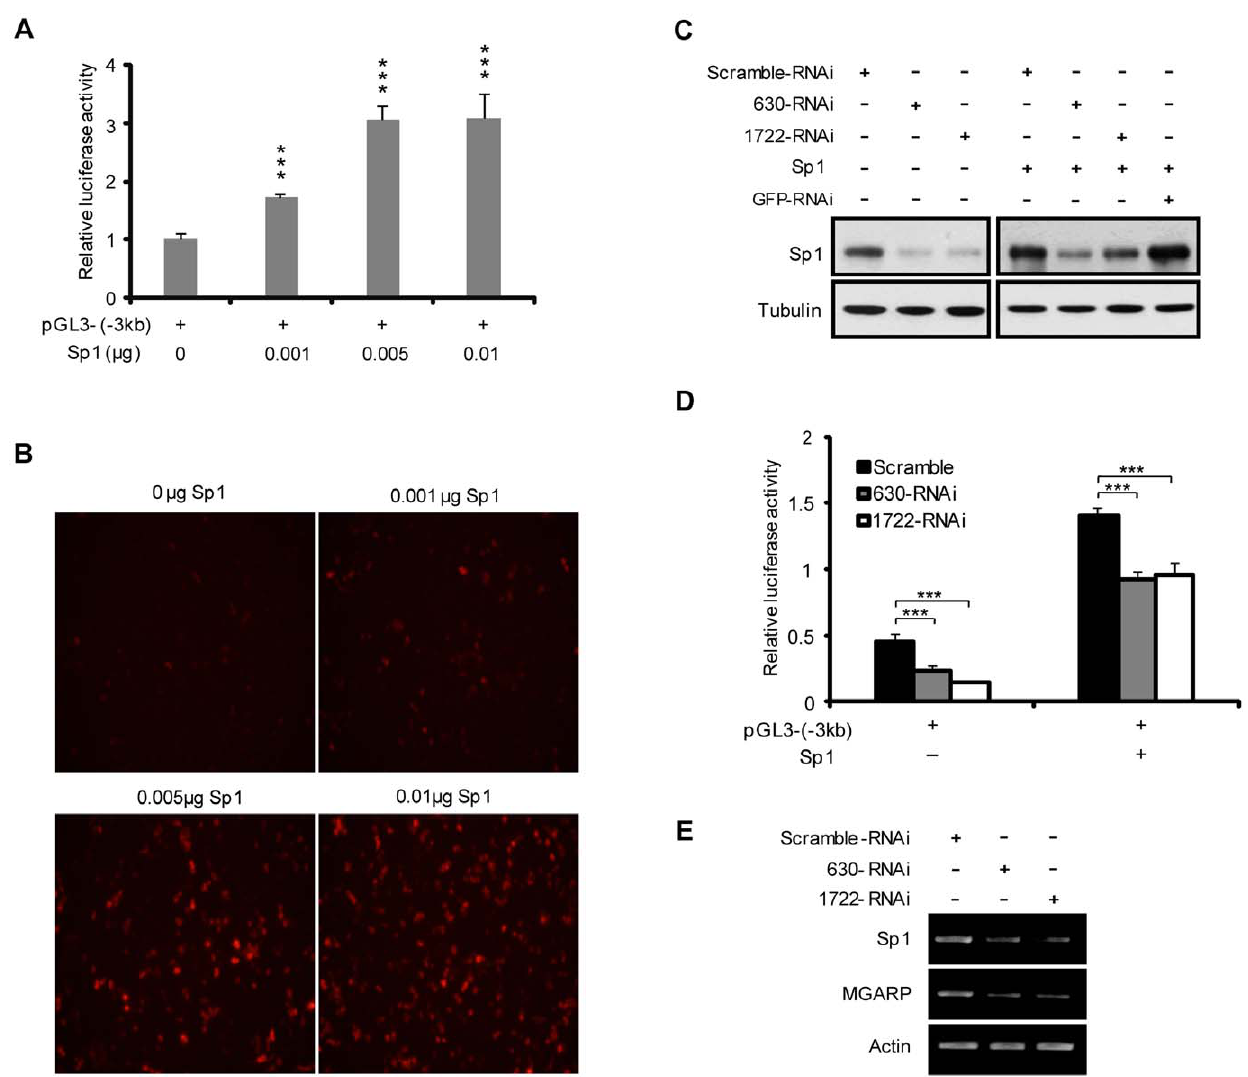
Figure 2. MGARP promoter activation is mediated by Sp1. A. Luc assay shows that Sp1 mediates the MGARP promoter activity in a dose- dependent manner. HEK-293T cells were co-transfected with pGL3-( 2 3 kb) and the increasing doses of Sp1 plasmids for Luc assay. B. Similarly, the pDsRed-MGARP( 2 3 kb) reporter and several doses of Sp1 plasmids were co-transfected into HEK-293T cells to examine the expression of red fluorescent protein at 72 hours post transfection. C. Western blotting shows that knockdown of Sp1 with Sp1-specific RNAi (630-RNAi and 1722-RNAi) reduces the expression of both endogenous and exogenous Sp1. The scramble-RNAi and RNAi targeting GFP were used as control. D. Luc assays to determine the effect of Sp1 knockdown on MGARP promoter activity. *** represents p , 0.001 (E) Semiquantitative RT-PCR analysis confirms that knockdown of Sp1 reduces the MGARP gene expression. Similarly, HEK-293T cells were transfected with control and Sp1-specific RNAi and harvested for semiquantitative RT-PCR analysis of MGARP messages